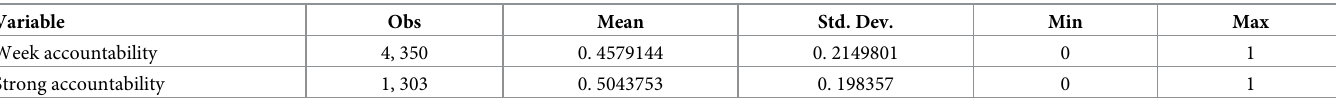
Table 3. Descriptive statistics of the degree of emphasis on the operation plan in the evaluation criteria for PPP projects under different accountability levels.